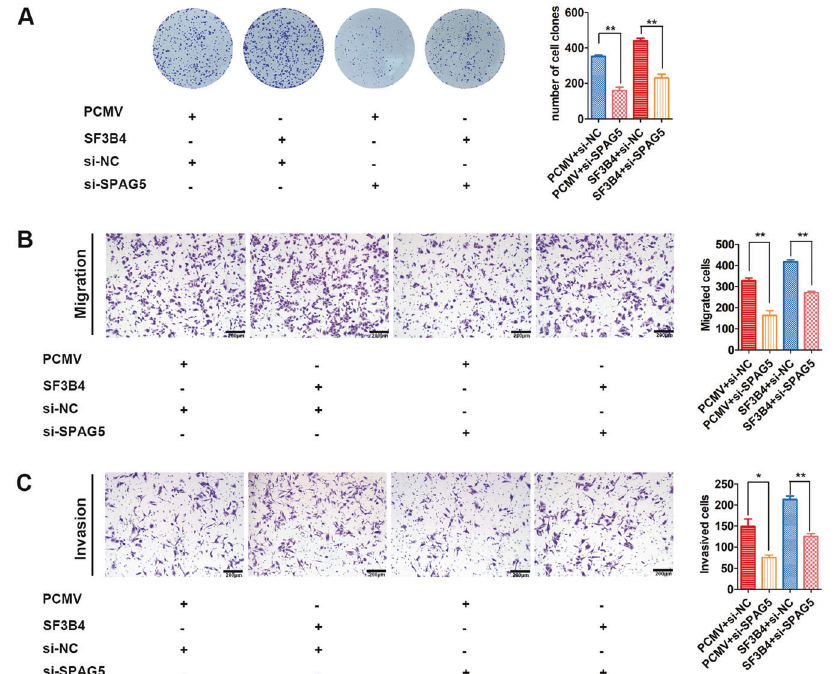
Fig. 7 Depletion of SPAG5 impairs the promotive effects of SF3B4. A Colony formation assays showed the effect of SPAG5 knockdown on changes in the proliferation ability of SF3B4-overexpressing HeLa cells ( n = 4 biologically independent samples). B , C Transwell assays were performed to assess the effect of SPAG5 de fi ciency on the migration and invasion abilities of HeLa cells stably overexpressing SF3B4 ( n = 3 biologically independent samples). P value was obtained by Unpaired t-test. * P < 0.05, ** P <